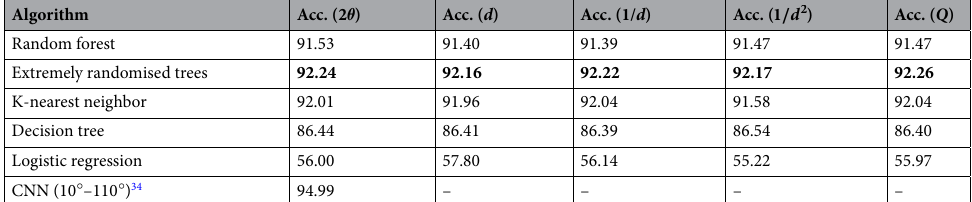
Table 1. Comparison of crystal system classification accuracy for various peak position notations and ML algorithms (in %). Accuracy is a ratio of correct classification to all classification for the test data. Notably, the accuracy of CNN taken from Ref. 34 is only for reference purpose because the dataset preparation and the evaluation condition were different from those used